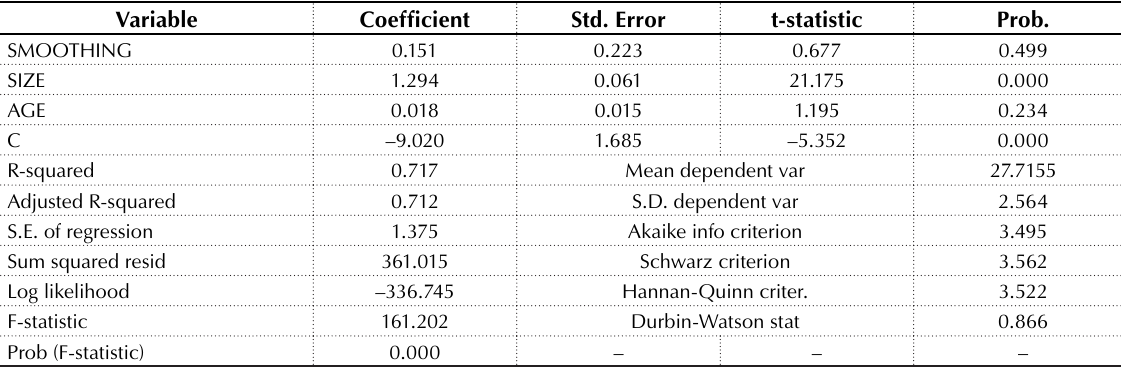
Table 3. Regression analysis for research model